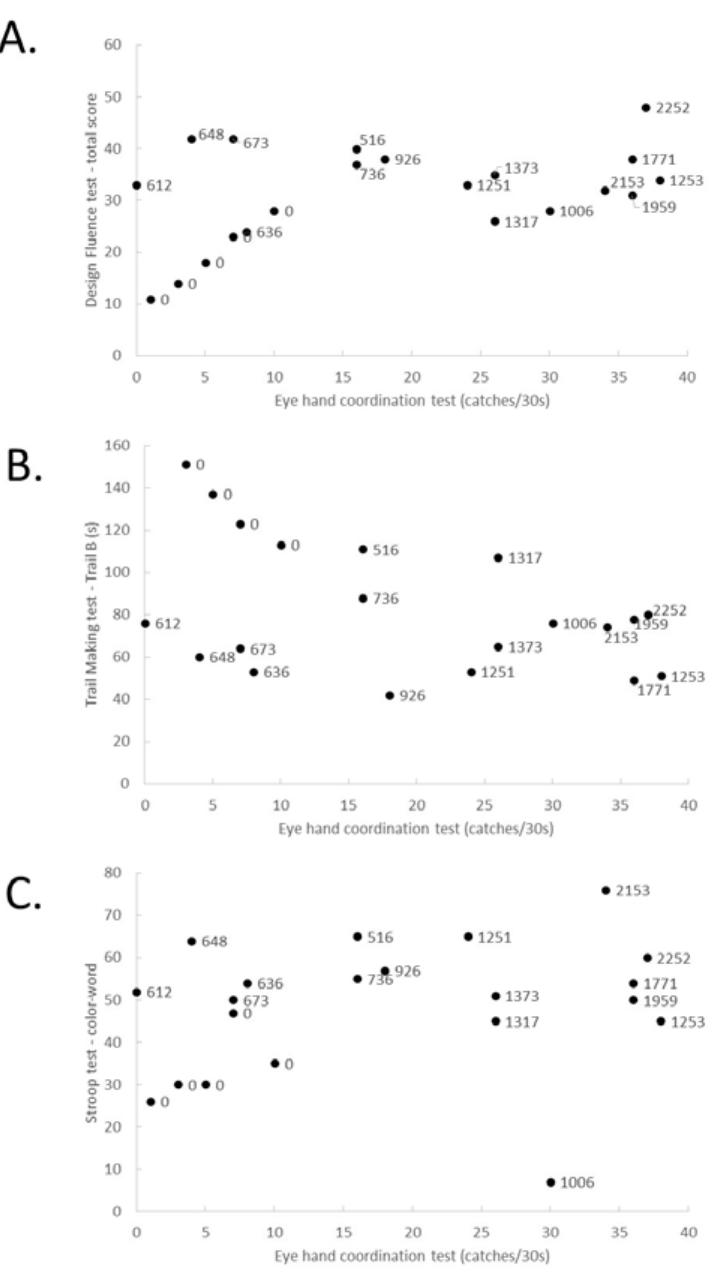
Figure 2. Exploration of the association between the level of eye-hand coordination and executive functioning and the level of